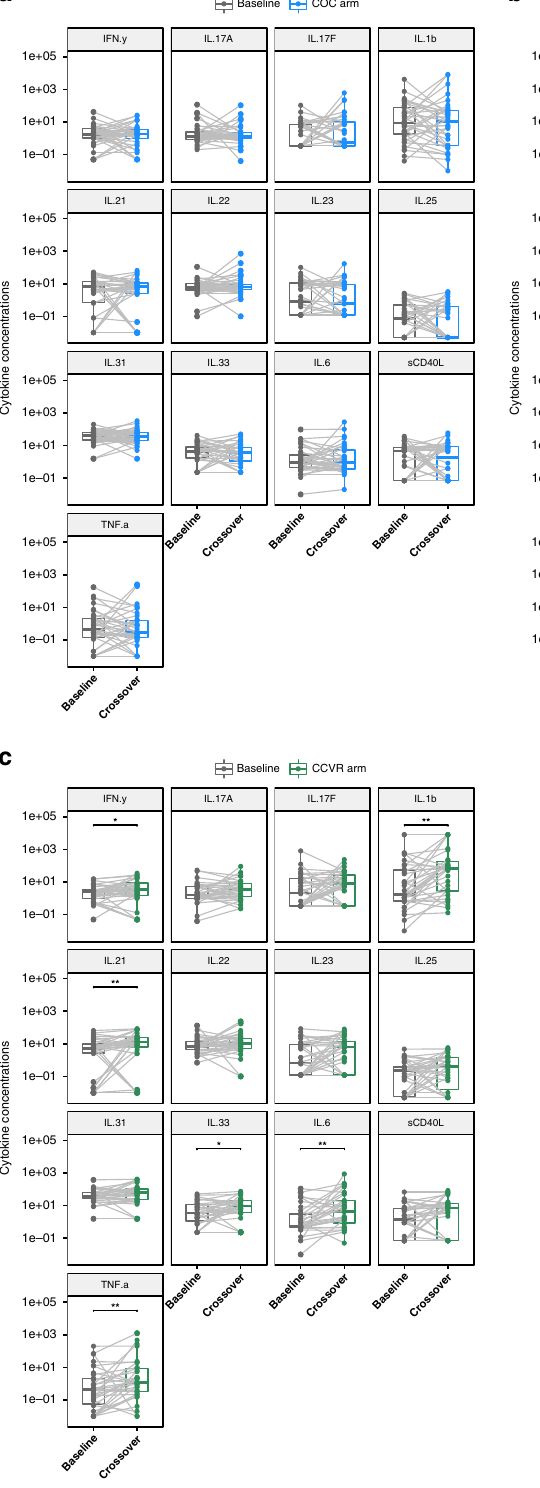
comparing adolescents in the COC arm versus those in the Net-En arm at crossover (ITT), CST-III was signi fi cantly less prevalent than CST-I in adolescents in the Net-En arm after adjustment (OR: 0.1, 95% CI: 0.02 – 0.5, P = 0.009), while CST-IV (0.5: 95% CI: 0.1 – 2.1, P = 0.343) and high in fl ammation (OR: 1.6, 95% CI: 0.4 – 6.5, P = 0.488) were not. When comparing adolescents in the COC arm versus the CCVR arm, there were no associations with